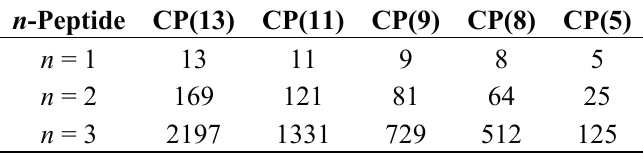
Table 2. The dimension of feature vectors of n -peptide composition with different cluster